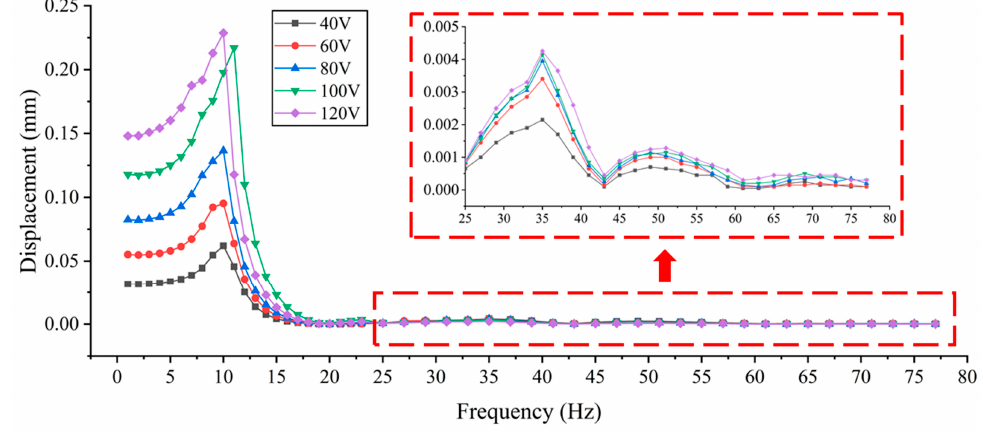
Figure 11. The amplitude results of the vibrator.